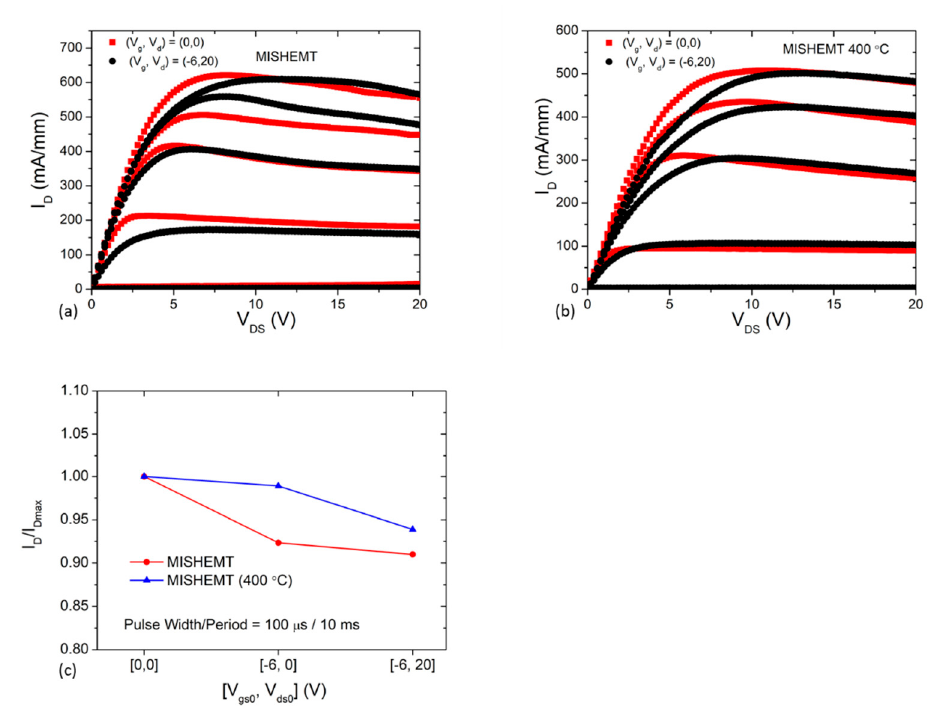
Figure 3. Pulsed I DS -V DS characteristics at quiescent bias points of (V gs0 , V ds0 ) = (0, 0), ( − 6, 20) for ( a ) LTE-AlN MISHEMTs, ( b ) 400 °C annealed MISHEMTs and ( c ) normalized I D with I Dmax for as-deposited LTE-AlN/AlGaN/GaN MISEMT and annealed MISHEMT at 400 °C vs. the quiescent bias points (V gs0 , V ds0 ) = (0, 0), ( − 6, 0), ( − 6, 20) V.